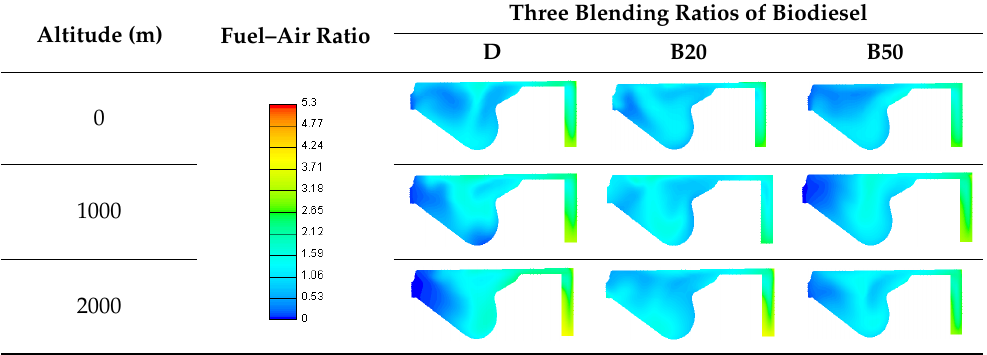
Table 4. Effect of plateau environment on distribution field of fuel–air ratio with three blending ratios.